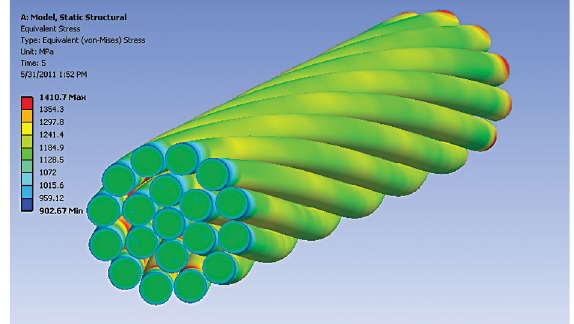
Fig. 10. Von Mises stresses for frictional contact settings – nonlinear case solution for 1 × 19 wire rope